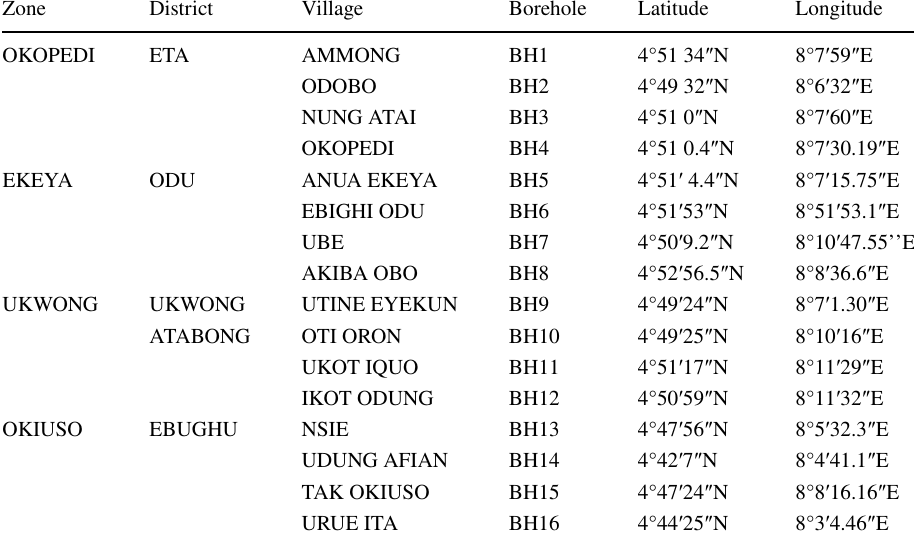
Table 1 Sampling location in okobo logal government